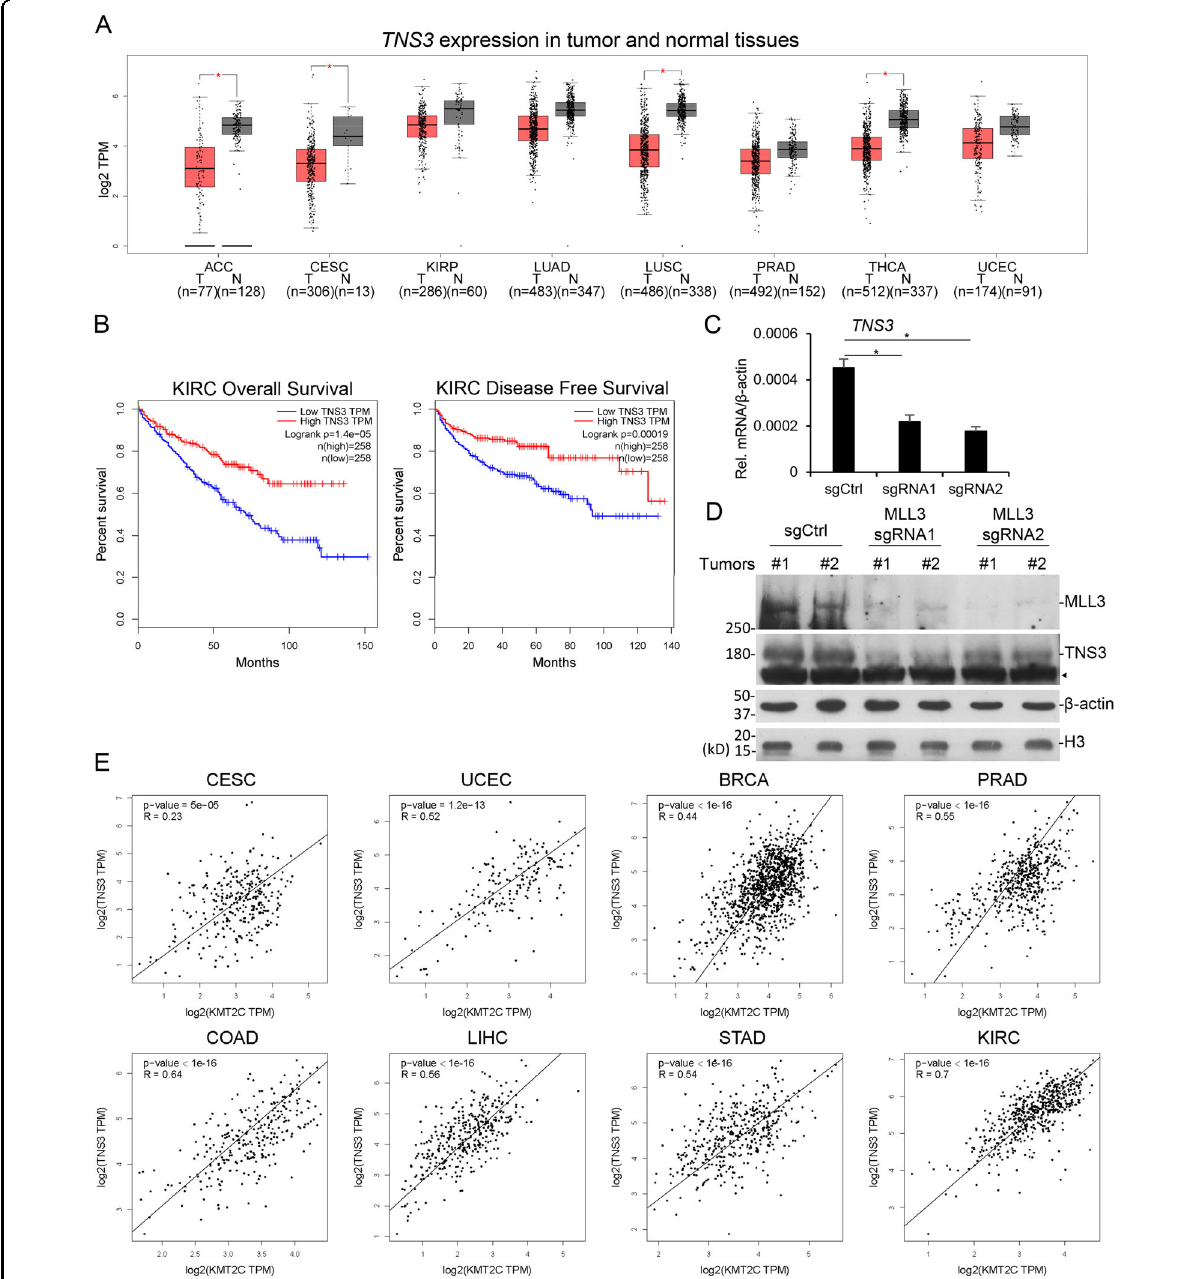
Fig. 6 Correlation of MLL3 and TNS3 in cancer patient tissues. A Boxplots showing the expression (log2 TPM) of TNS3 in multiple tumor and normal tissues in TCGA database. B The TCGA RNA-seq data of kidney cancer tissues were analyzed. Overall survival (OS) and disease-free survival (DFS) were analyzed and plotted using the Kaplan – Meier method. The survival rates for patients with high or low TNS3 expression are plotted as red or blue lines, respectively. The number of patients in each group is shown in parentheses. p-Values were calculated using a log-rank test. C The mRNA levels of TNS3 of tumors shown in (Fig. 1E) were determined by qRT-PCR. Three tumors from each group were randomly picked. Histograms are presented as mean ± SEM ( n = 3). D Two tumors from each group were random picked and the protein levels of MLL3 and TNS3 were analyzed by WB with indicated antibodies. E The correlation of MLL3/KMT2C and TNS3 in multiple cancer tissues from TCGA datasets was analyzed. p -Values were calculated using a log-rank test. * P < 0.05. ◄ represents unspeci fi c